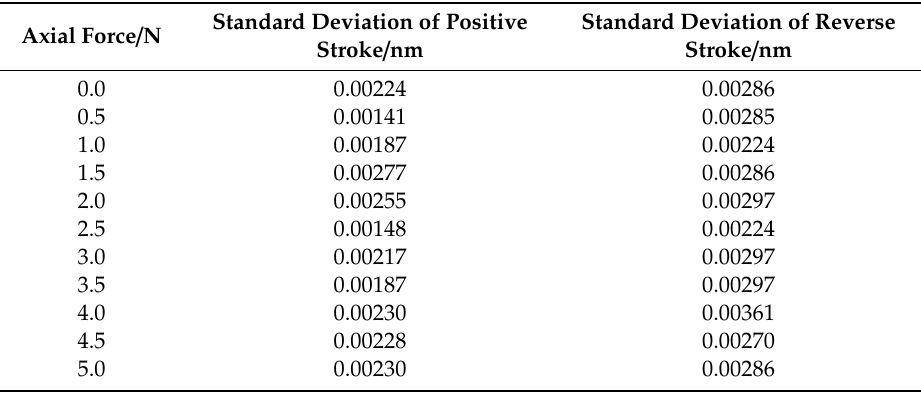
Table 4. Standard deviation of each axial force gradient in the same stroke.